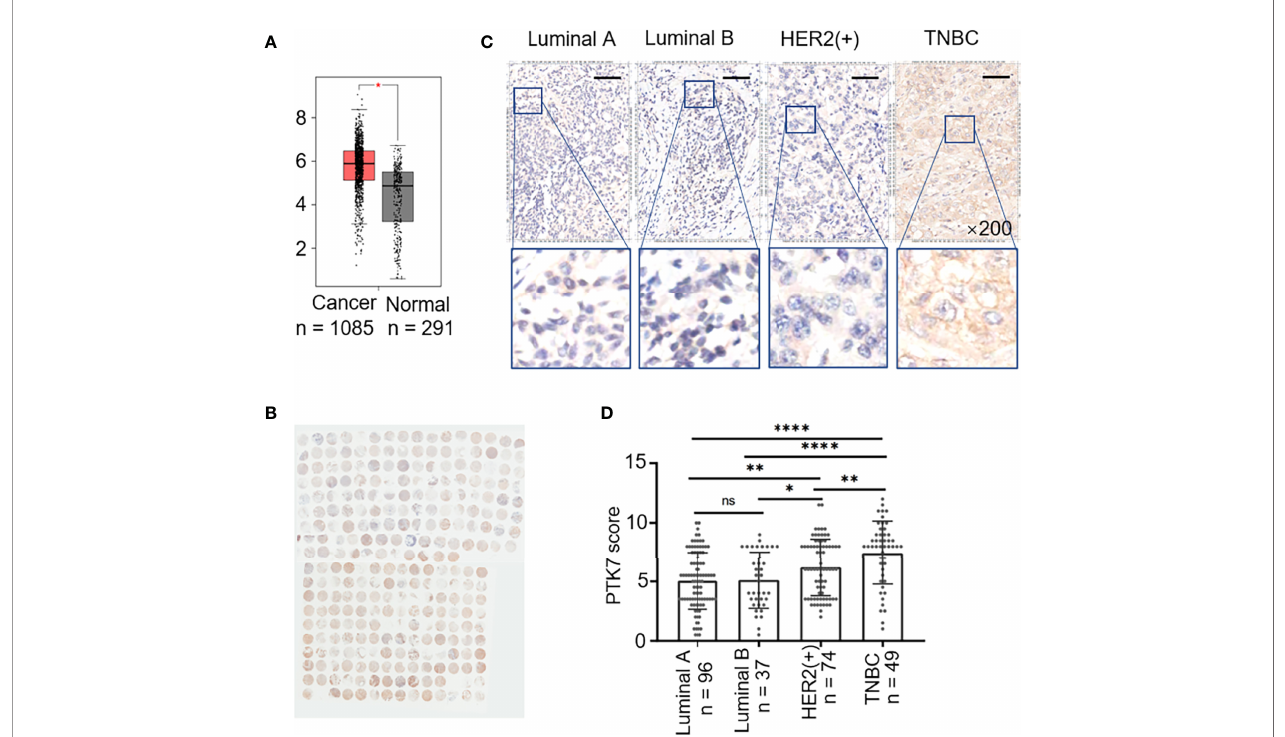
FIGURE 1 | PTK7 expression is upregulated in breast cancer. (A) Box plots of PTK7 expression in breast invasive carcinoma (BRCA) using GEPIA: Gene Expression Pro fi ling Interactive Analysis system (http://gepia.cancer-pku.cn/). BRCA tumor (T) and non-tumor (N) TCGA normal and GTEx dataset included 1,085 tumor cases (T) and 291 non-tumor cases (N) was selected to observe the expression of PTK7. (B) IHC staining of PTK7 expression in breast cancer tissue microarray. (C) Representative images from PTK7 IHC staining in Luminal A, Luminal B, HER2(+) and TNBC subtypes of breast cancer tissues. Magni fi cation, ×200; scale bars, 100 m m. (D) Scatter dot plots of PTK7 expression in tumors with different molecular subtypes. Data were analyzed using one-way ANOVA and Tukey ’ s multiple comparisons test and are shown as mean ± s.d. * P < 0.05, ** P < 0.01, **** P < 0.0001. ns, no signi fi